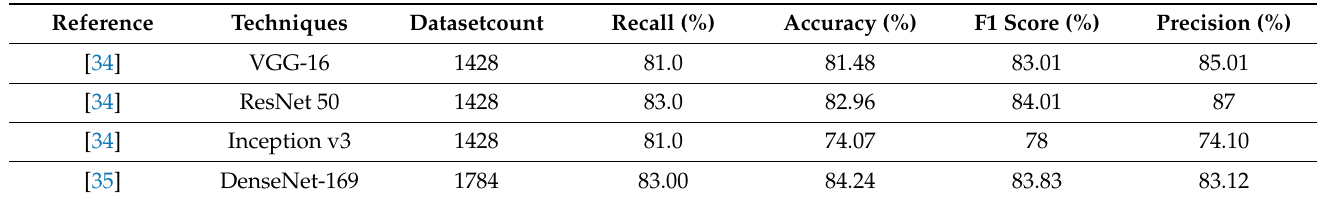
Table 1. Data analysis for detection of monkeypox disease detection for feature extraction model.